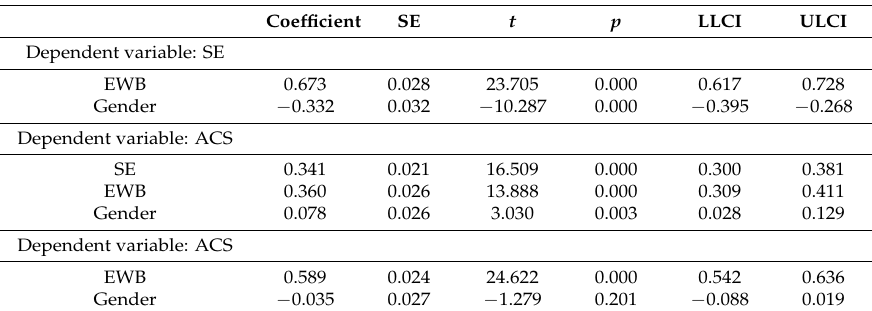
Table 2. Results of the mediational analysis.